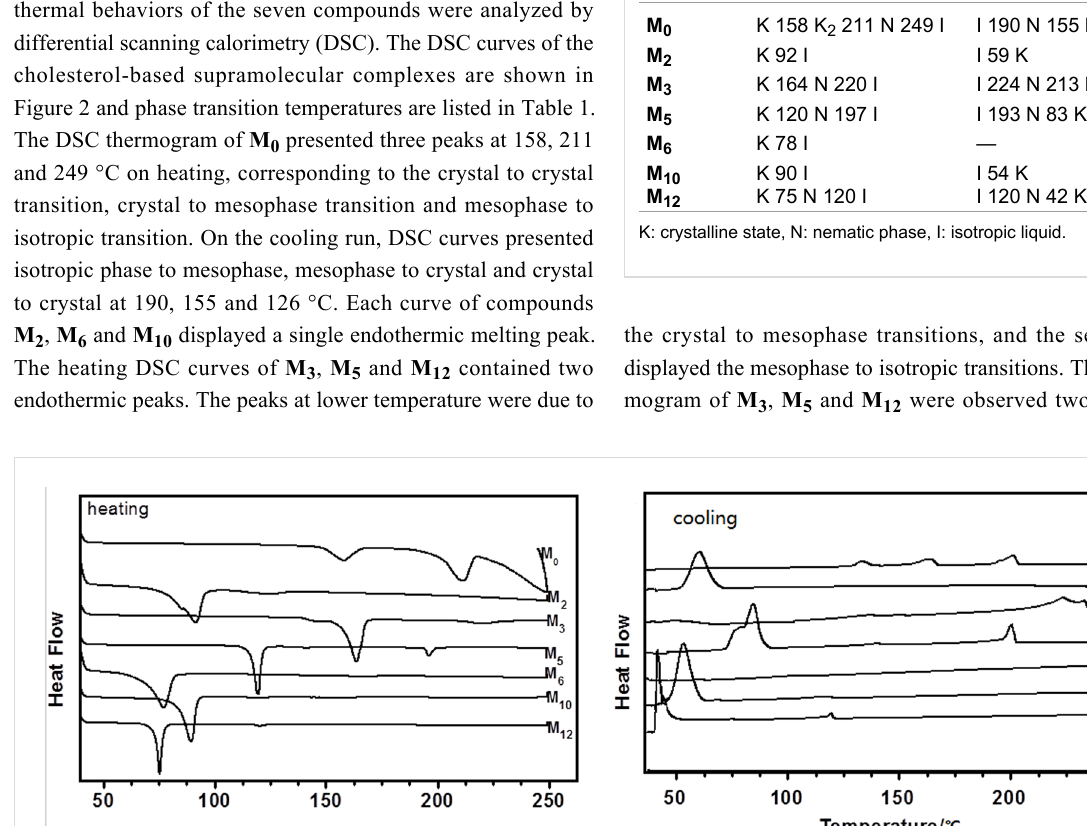
Liquid crystal properties of the synthesized compounds